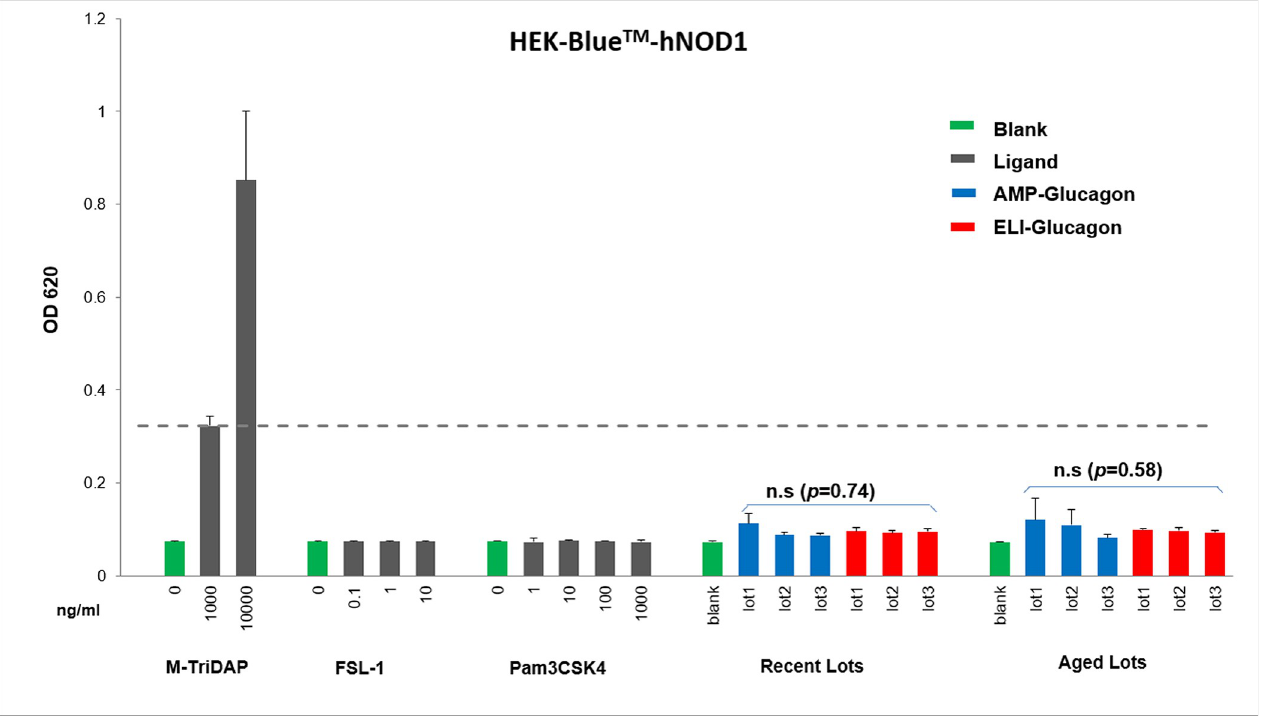
Fig 2. Comparison of innate immune response of AMP-Glucagon and ELI-Glucagon in HEK-Blue ™ -hNOD1 cells. Each bar represents mean ± stdev of 3–5 times of independent experiments. n.s, no significance by two- way ANOVA test.